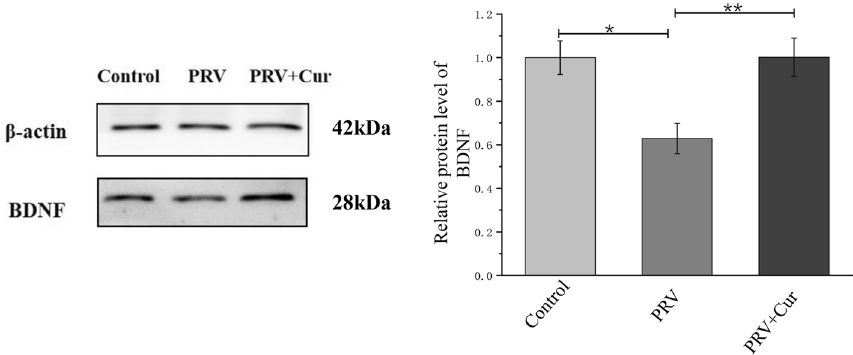
Figure 3. The protein levels of BDNF in hippocampal neurons. The intensity of BDNF bands was normalized with that of β-actin bands detected in the same blot. Cur curcumin, BDNF brain-derived neurotrophic factor. n = 3, represents three biological replicates, each performed in triplicate. *P < 0.05, **P < 0.01, based on one- way analysis of variance (ANOVA) followed by least significant difference (LSD) post hoc test for multiple